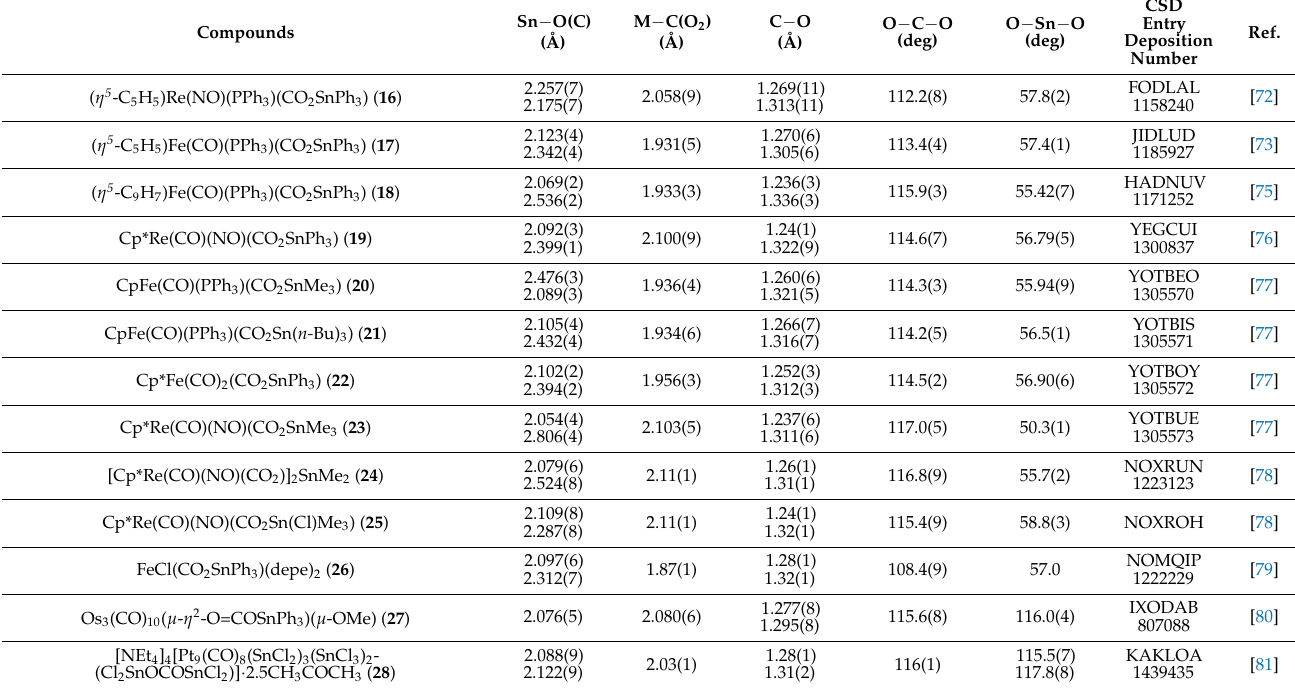
Table 7. Selection of structural parameters found in metallocarboxylato tin complexes. Compounds Deposition